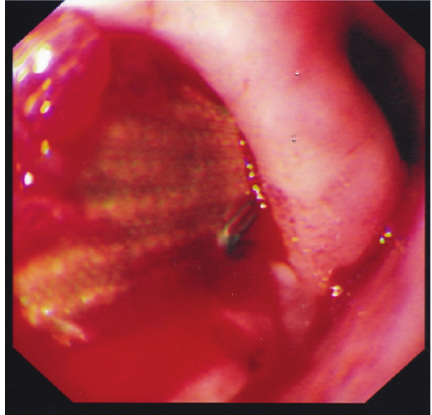
Figure 3: Esophagogastroscopy showing bleeding in the mid oesophagus with the aortic stent eroding into the